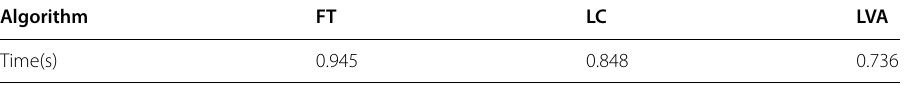
Table 4 Running time of the three algorithms Algorithm